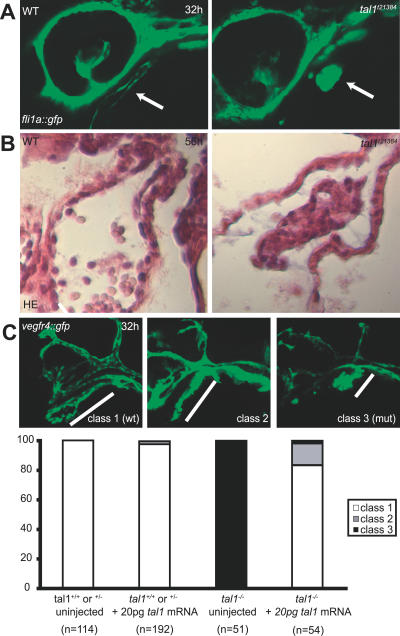
Defects in Endocardial Development in tal1t21384 Mutants(A) Confocal images of the head region from embryos transgenic for fli1a:gfp at 32 hpf. Arrows indicate the location of the endocardium. In the wt endocardium, a lumen is visible, which is absent in tal1t21384 mutants.(B) Transversal sections of wt and tal1t21384 mutant heart ventricles at 56 hpf stained with hematoxylin/eosin. In wt embryos, the endocardium forms an epithelium attached to the myocardium, and blood cells are visible within the heart tube. In the tal121384 mutant heart, the endocardium fails to form an epithelium and is only present in the heart ventricle.(C) Rescue of endocardial defects. Maximum z-projection of a stack of confocal images of embryos carrying the vegfr4:gfp transgene. Embryos were divided into three classes based on their endocardial phenotype. Class 1: wt length of the endocardium with normal tube formation (wt phenotype). Class 2: wt length of the endocardium but no tube formation (intermediate phenotype). Class 3: short endocardium with no tube formed (mutant phenotype). All embryos homozygous or heterozygous for the wt allele are in class 1, whereas all embryos homozygous for the tal1t21384 allele are in class 3, showing the high penetrance of this phenotype. In 43 out of 54 embryos homozygous for the tal1t21384 allele (83%), the endocardial phenotype can be rescued to class 1 through injection of low amounts of wt tal1 mRNA (20 pg per embryo), whereas most of the remaining (8/54, 15%) display an intermediate phenotype (class 2).